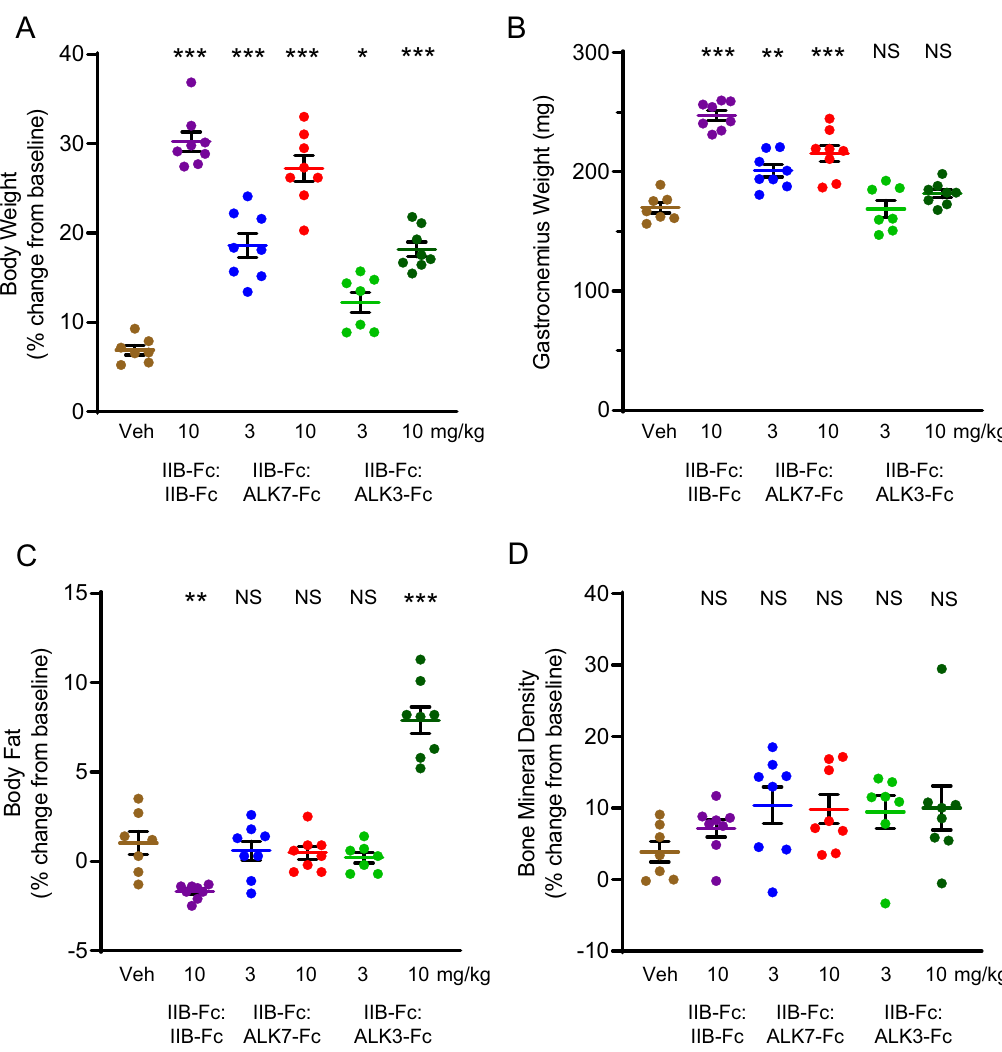
Figure 5. Activity of IIB-Fc:ALK7-Fc and IIB-Fc:ALK3-Fc heterodimers in wild-type mice. Twelve-week-old wild-type C57BL/6 mice were injected s.c. with IIB-Fc:IIB-Fc ( n = 8, 10 mg/kg), IIB-Fc:ALK7-Fc ( n = 8, either 3 mg/kg or 10 mg/kg), IIB-Fc:ALK3-Fc ( n = 7, 3 mg/kg or n = 8, 10 mg/kg), or vehicle control ( n = 7, PBS) twice weekly for 28 days. ( A ) Percentage change in mouse total body weight from day -1 to day 28. ( B ) Weight of the gastrocnemius muscle isolated by dissection on day 28. ( C ) Percentage change in total fat mass normalized to body weight from day -1 to day 27 as assessed by NMR. ( D ) Percentage change in bone mineral density from day -1 to day 27 as assessed by DXA. Data are means ± SEM. See Supplemental Table S3 for associated statistics. Veh vehicle; mg/kg milligrams per kilogram; NS not significant. * P < 0.05, ** P < 0.01, *** P < 0.001 vs.